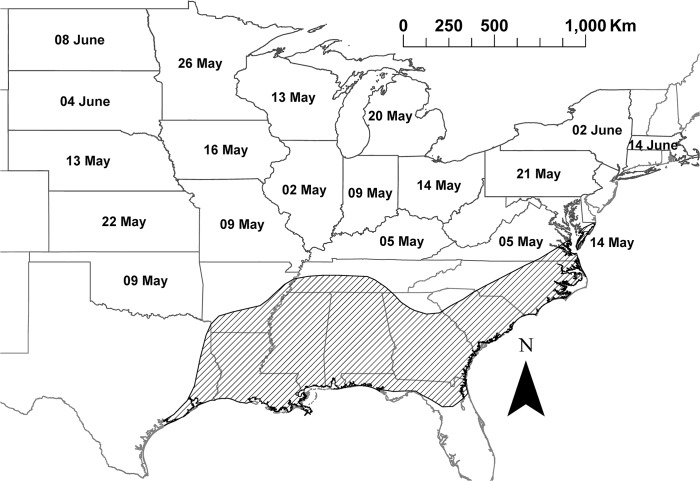
Average arrival date of Empoasca fabae at different states across continental United States during 1951–2012, and the overwintering range (stripe shaded region; adapted from Taylor and Shields [29]).Map was generated with spatial data on administrative state boundaries available freely through United States Census Bureau (https://www.census.gov/geo/maps-data/data/tiger-line.html).